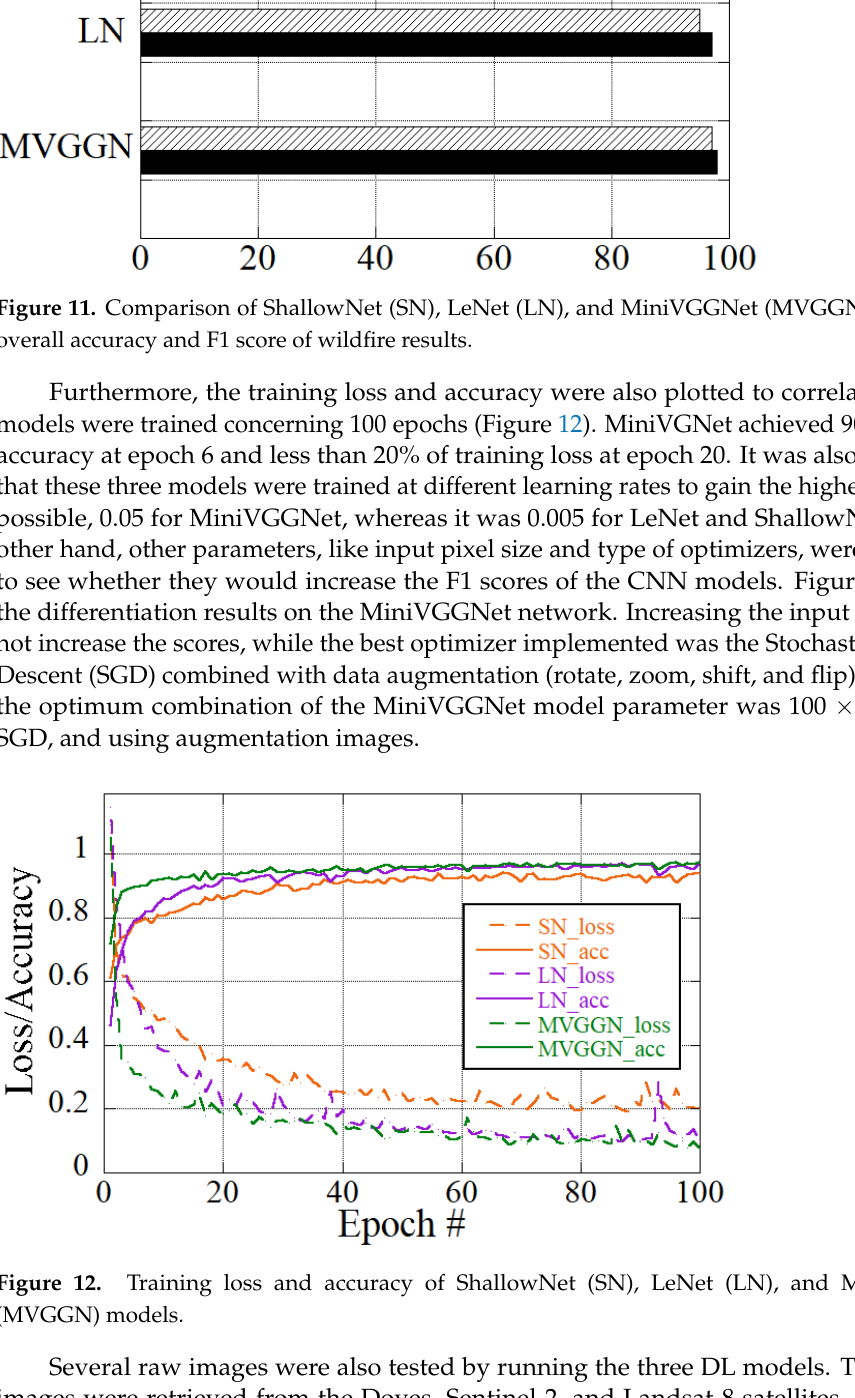
Figure 13. F1 score of wildfire results using MiniVGGNet model with different input pixel sizes and optimizer types.